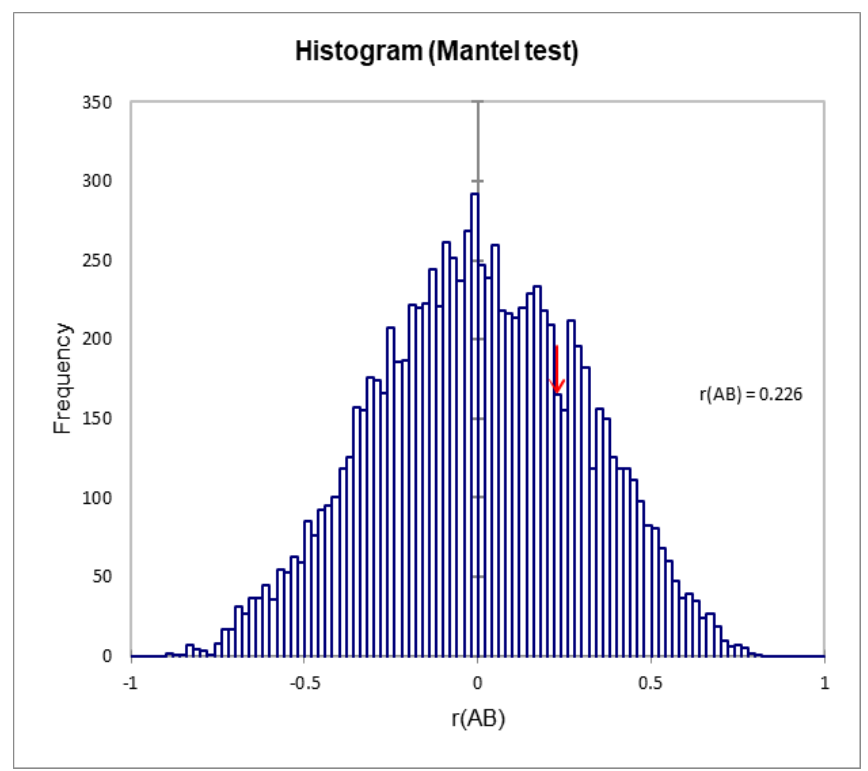
Figure 8. Mantel test between geographical distance and genetic distance among different populations of A. spinosa.